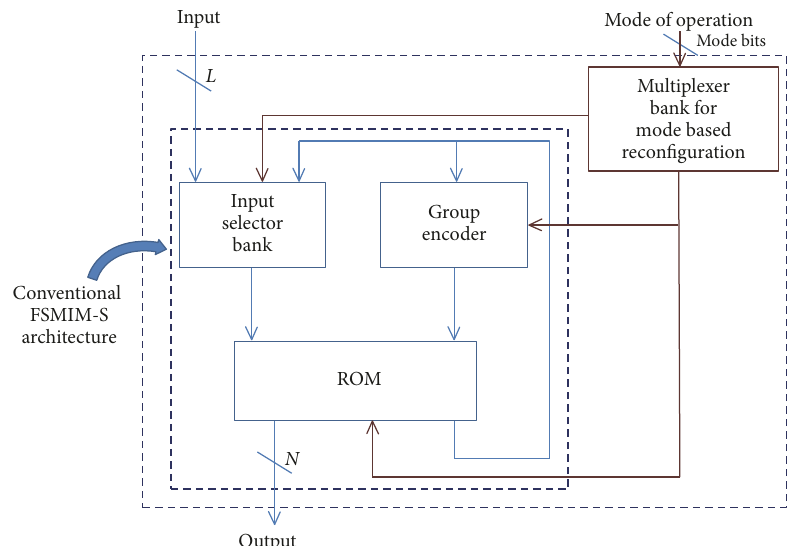
Figure 1: Reconfigurable FSMIM-S